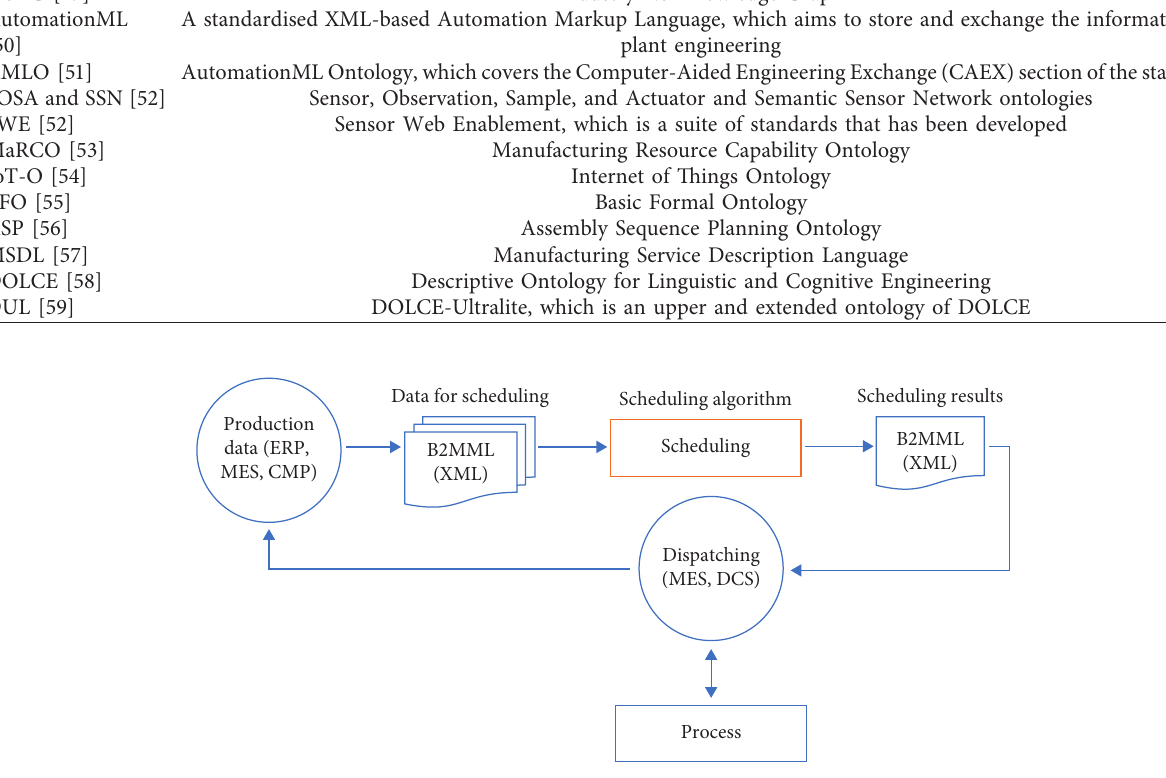
Figure 10: Flexible scheduling supported by production ontology data